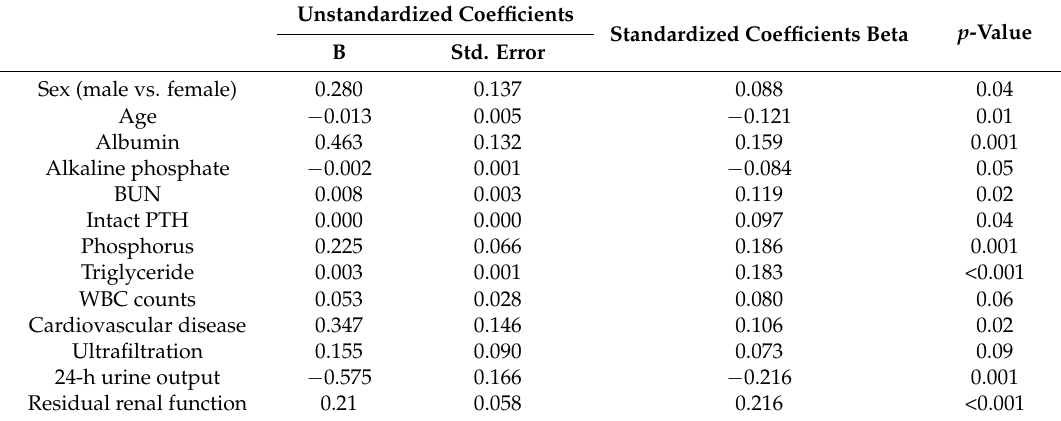
Table 5. Multivariate linear regression of serum uric acid levels with clinical parameters at baseline. Unstandardized Coefficients Standardized Coefficients Beta p -Value